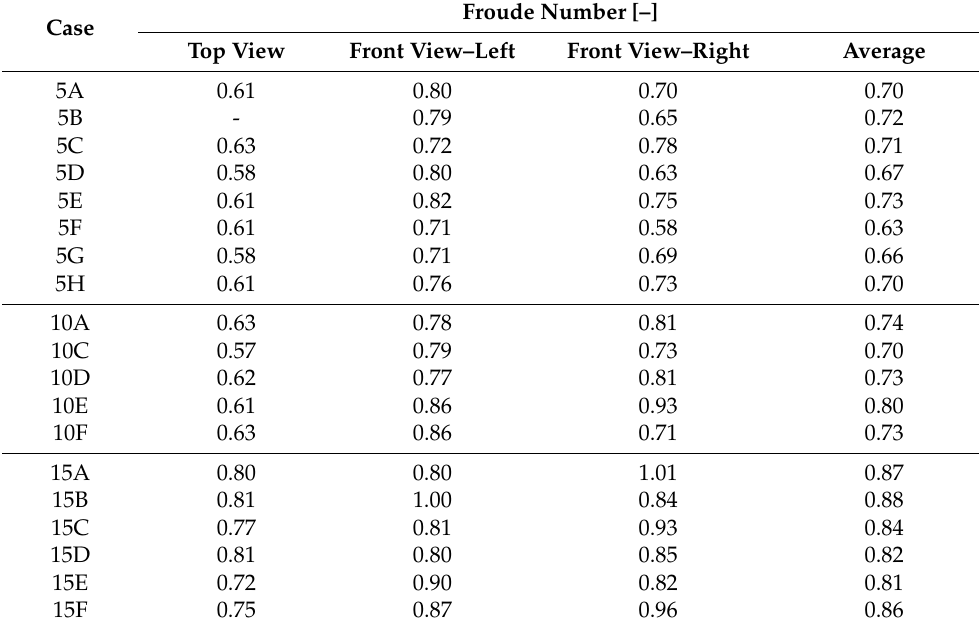
Table 2. Froude number calculated from the processing of the